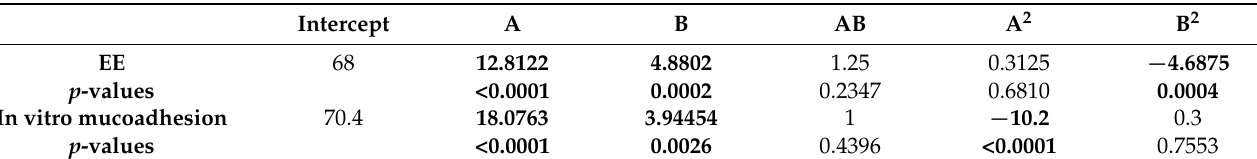
Table 6. ANOVA coefficients table for both the responses.